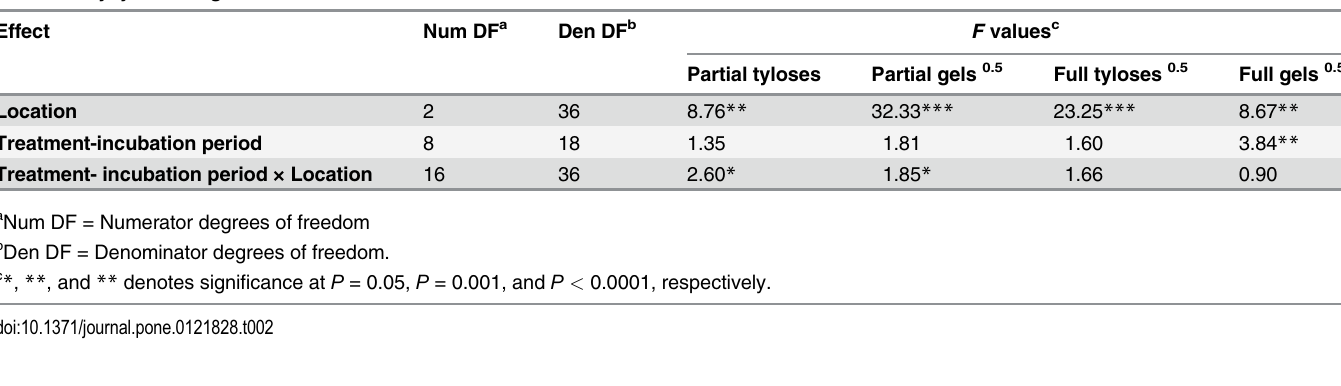
Table 2. ANOVAs of effects of nine treatment-incubation period combinations (NINW-0 MPI, IW-0.5 MPI, IW-1 MPI, IW-1.5 MPI, IW-2 MPI, NIW-0.5 MPI, NIW-1 MPI, NIW-1.5 MPI, NIW-2 MPI), stem location (2, 0, -2 cm), and their interaction on the percentages of xylem vessels partially or fully- occluded by tyloses or